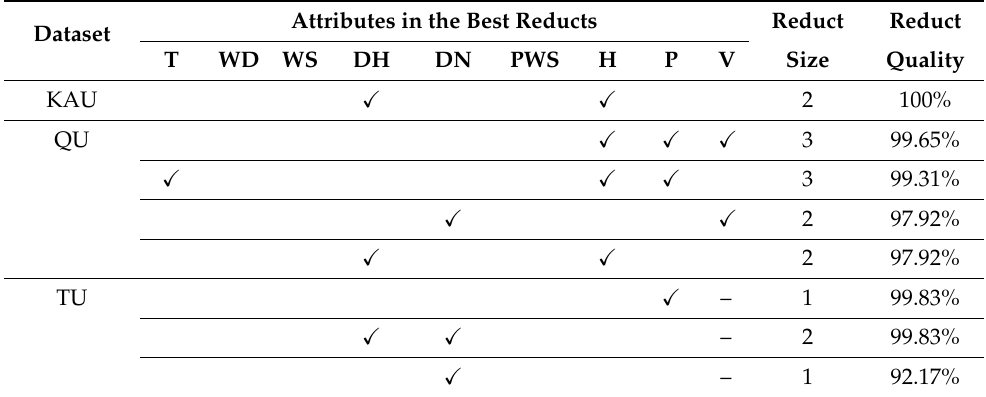
Table 5. The 5-class or the 10-class decision attribute: The best reducts for five independent runs.